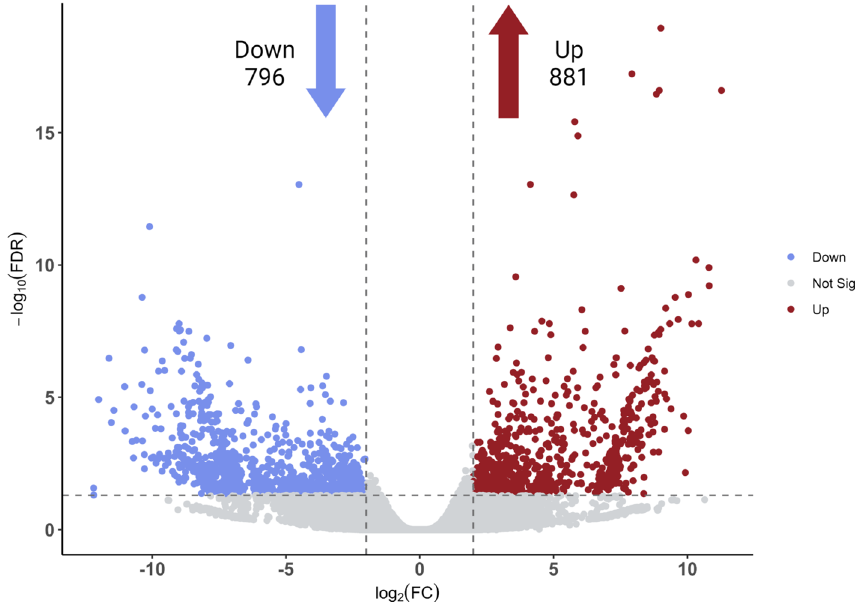
Figure 1. Volcano plot representation of differential expression. Red and blue points mark the transcripts with significantly increased or decreased expression in drought stressed plants versus control plants, respectively (FDR < 0.05). The x-axis shows log2 fold-changes in expression and the y-axis log10 false discovery rate of a transcript being differentially